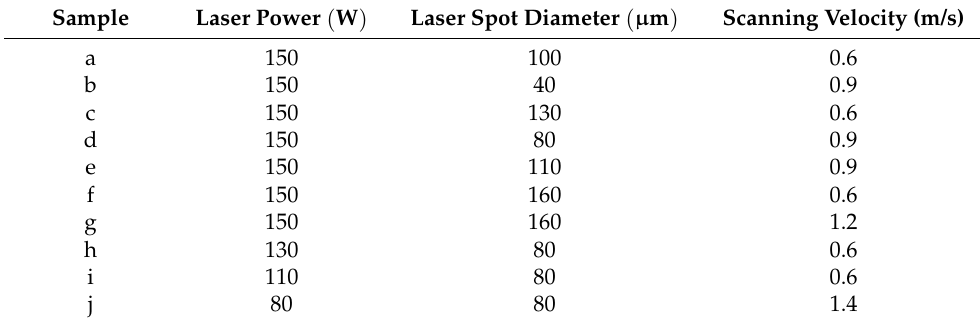
Table 7. Parameter sets of fabricated samples. A hatch space of 115 µ m was used.